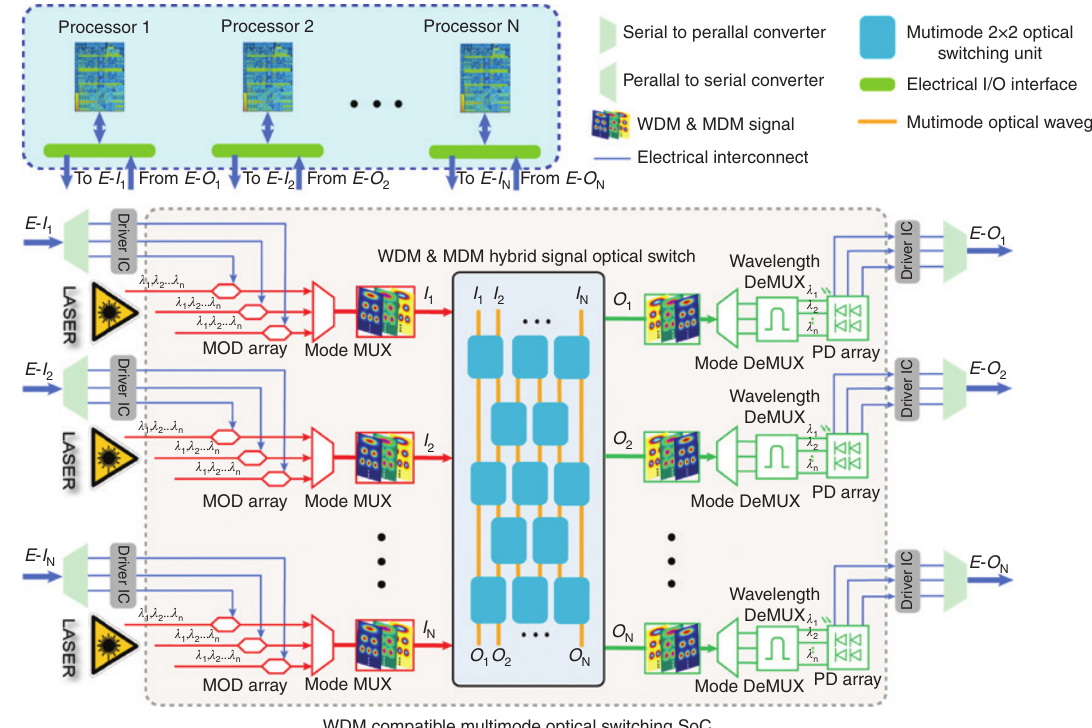
Figure 1: Architecture of a wavelength-division multiplexing (WDM)-compatible multimode optical switching system among arbitrary N processors.